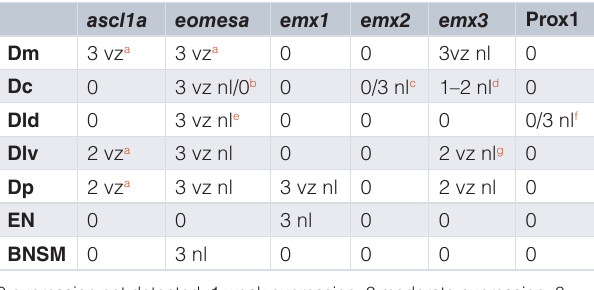
Table 1. Summary of gene expression pattern in the adult zebrafish